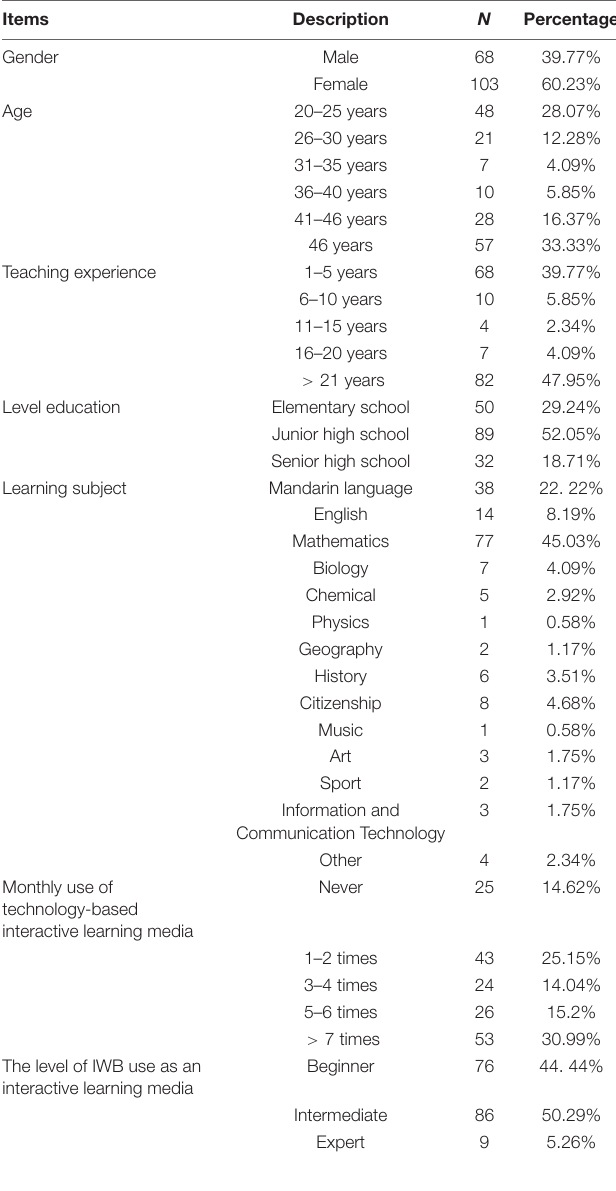
TABLE 2 | Basic information of